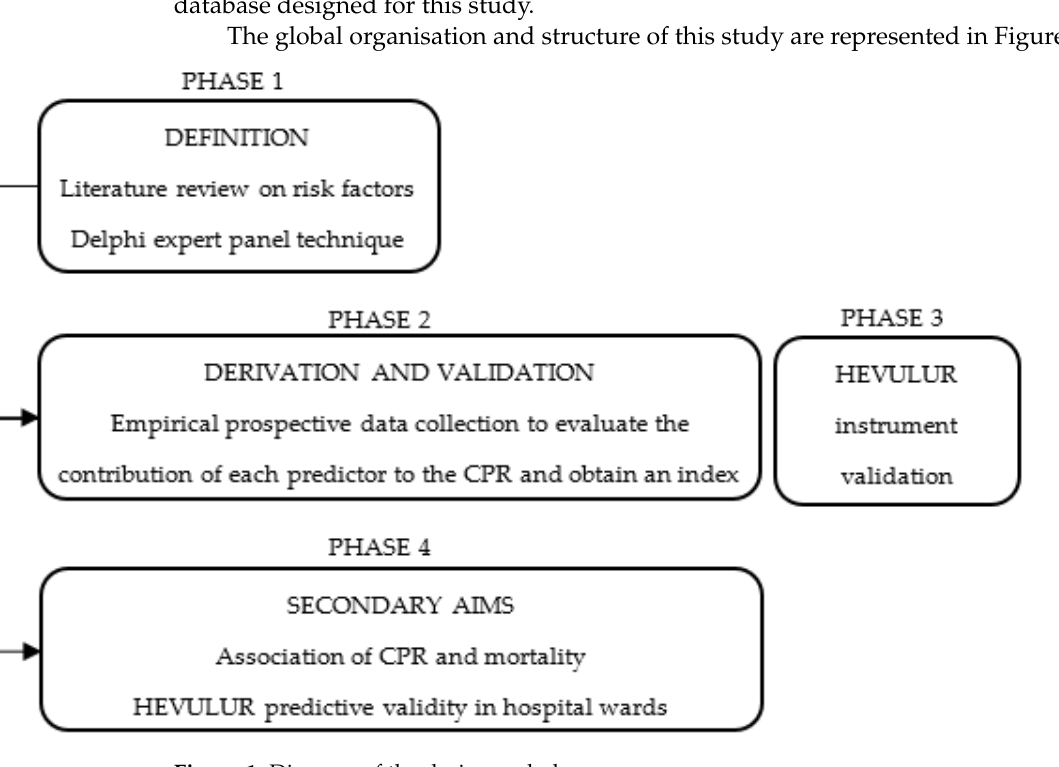
Figure 1. Diagram of the design and phases.